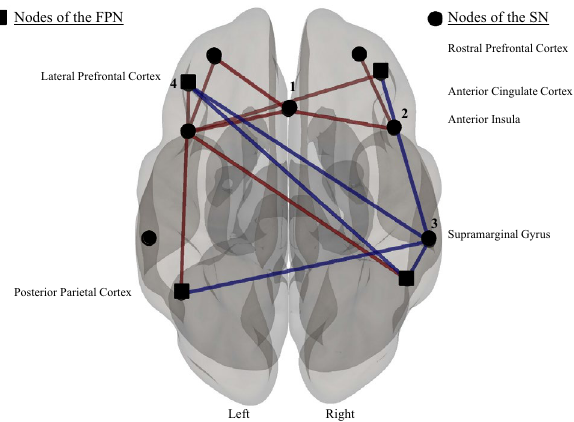
Figure 1. Seed-to-seed functional connectivity using Network Based Statistics (p-FWE = 0.04). Red lines represent increased rs-FC while blue lines represent reduced rs-FC. The sphere represent nodes of the SN while the squares represent the nodes for the FPN. Image is displayed using neurological convention. Contrast image concussed > controls, shows that concussed participants showed significantly increased connectivity in the frontal nodes including the anterior insula and significantly reduced connectivity amongst the lateral prefrontal and parietal nodes when compared to control participants. 1 = Anterior Cingulate Cortex; 2 = Anterior Insula; 3 = Supramarginal Gyrus; 4 = Lateral Prefrontal Cortex. Image generated using CONN, an open- source computational platform available at https ://web.conn-toolb ox.org/